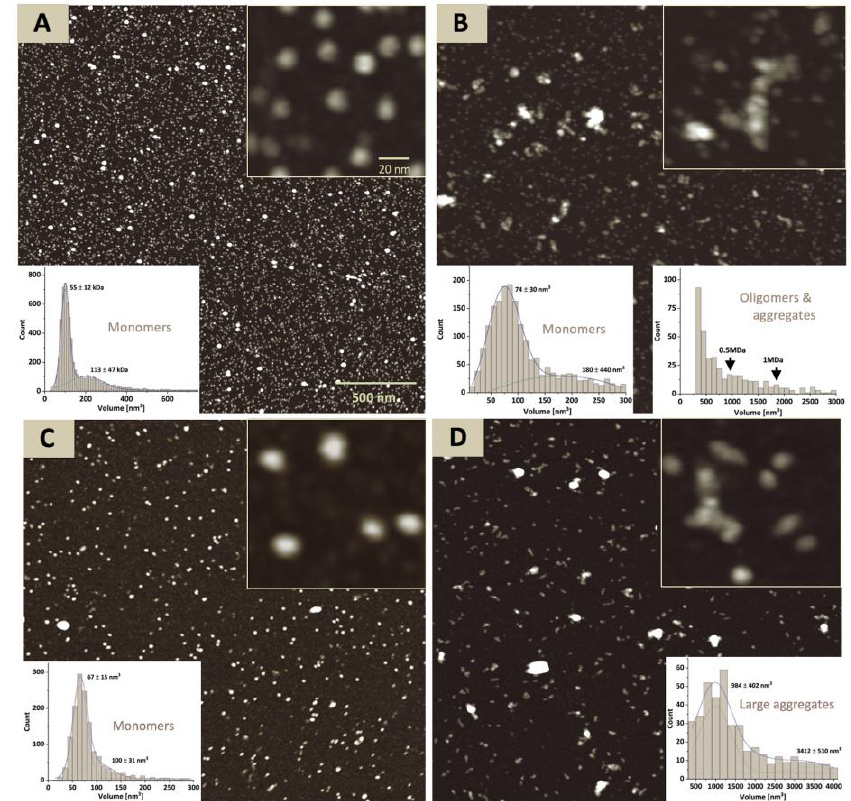
Figure 2. Atomic force microscopy of Tyrp1tr. The full-field images of the Tyrp1tr stored at 4 °C (Panel A ), pre-incubated at 37 °C × 24 h (Panel B ), and fractions concentrated from the Peak A (Panel C ) and Peak B (Panel D ) (see Figure 3). The inserted graphs show the particle volume distributions for the monomers (Panels A and C ) and monomers and/or larger aggregates (Panels B and D ). The inserted pictures show the enlarged fragments of each image.